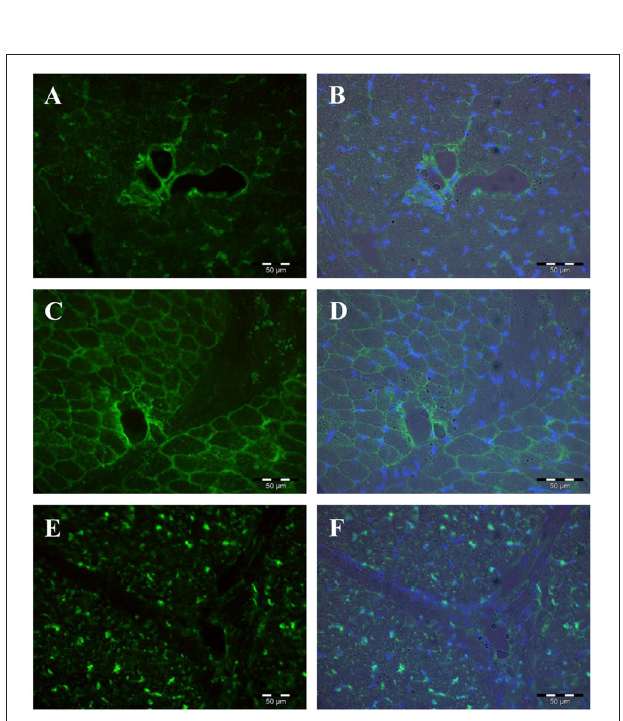
Protein Abundance of PLIN1–5 in